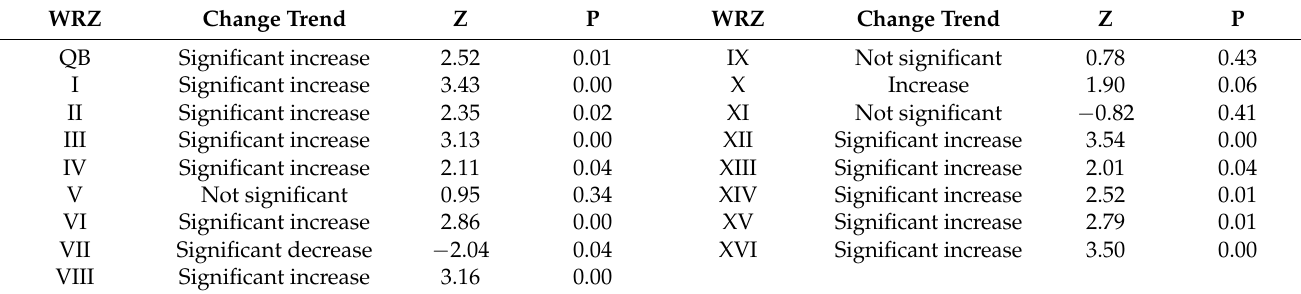
Table 6. Test results of the air temperature trend in the Qaidam Basin from 1990 to 2020.